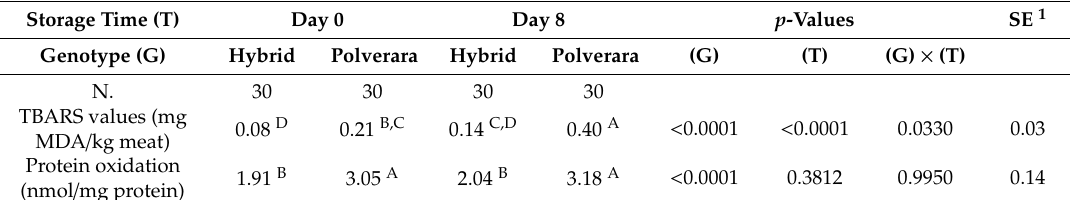
Table 4. E ff ect of genotype (Hybrid vs. Polverara) and day of storage (0 vs. 8) and their interaction on the TBARS values and protein oxidation of leg meat over 8 days